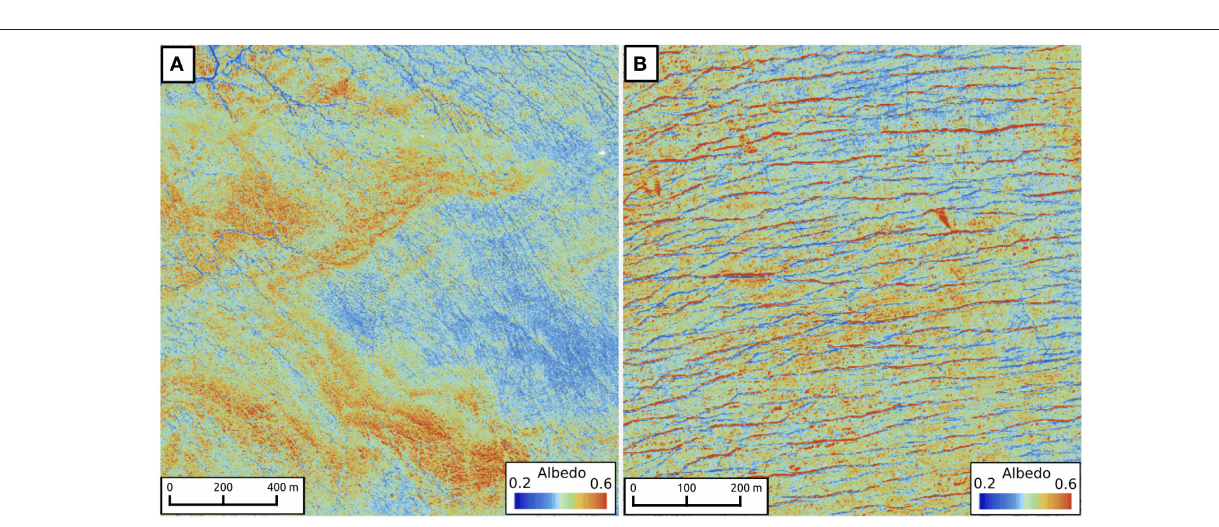
FIGURE 10 | (A) Foliation patterns in the dark region. (B) Fractures filled with remnant snow